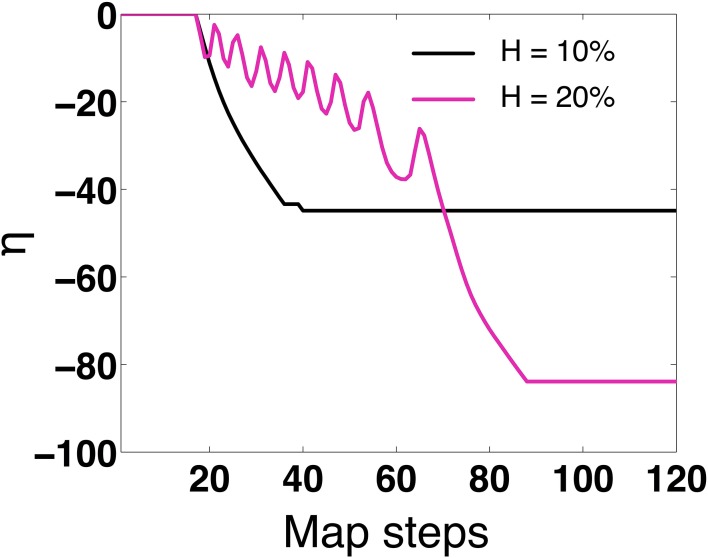
Map evolution of η. We validate that under STDP, the map evolves to stationary values of η that allow in-phase synchronization. For H = 10 the map predicts η = −44 (as compared to η = −40 for 2-MCI simulations). For H = 20 the map predicts η = −82 (as compared to η = −80 for 2-MCI simulations).